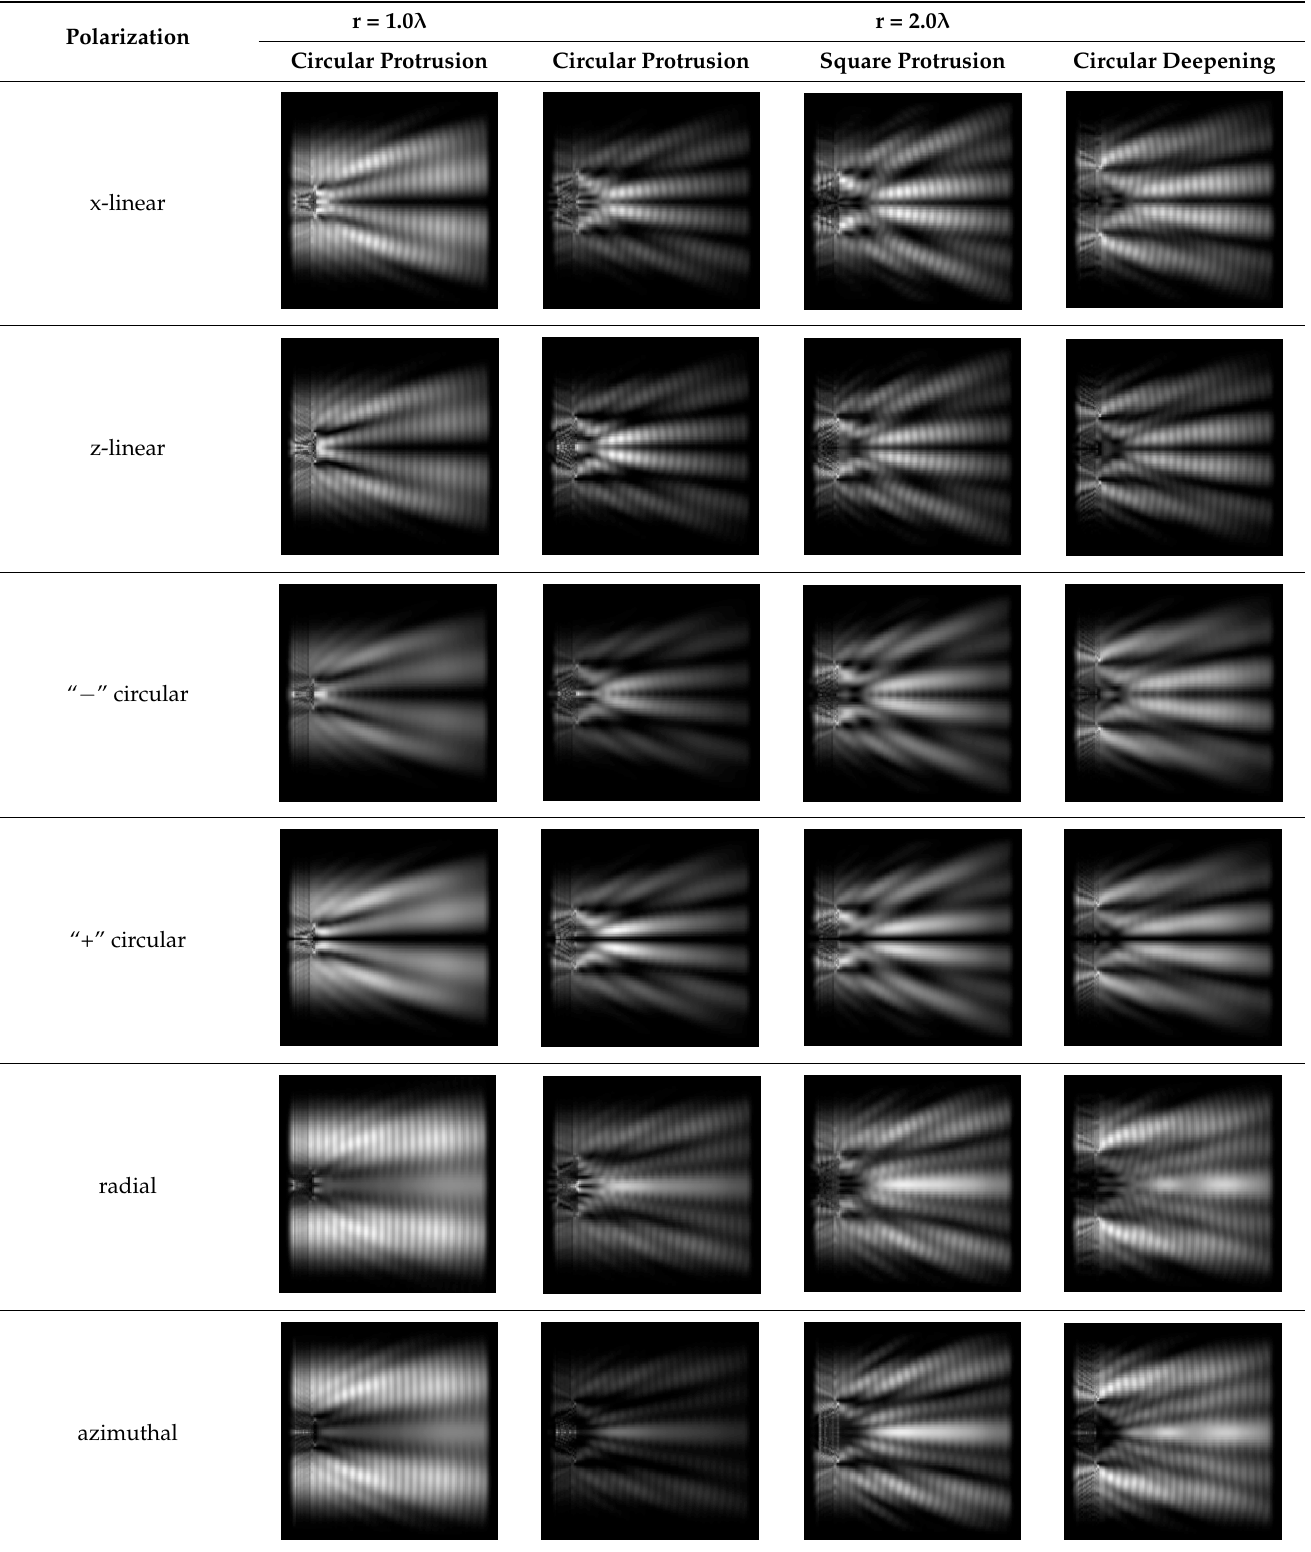
Table 1. The diffraction of Laguerre–Gauss mode (0,1) by surface micro-defects in plane xz, | E | 2 , [ − 6.96 λ ; 6.96 λ ].